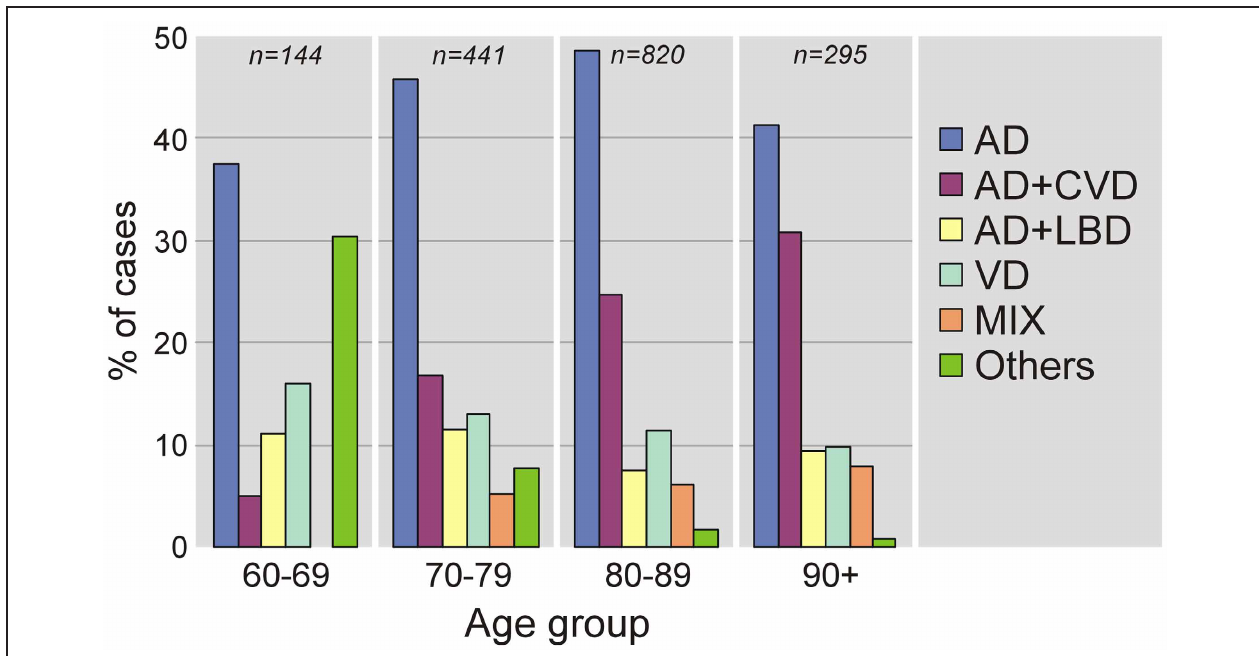
FIGURE 1 | Age-related frequency of neuropathologic types of dementing disorders. AD, Alzheimer’s disease; CVD, cerebrovascular dementia; LBD, Lewy body dementia; VaD, vascular dementia; MIX, mixed dementia (AD + cerebrovascular encephalopathy).